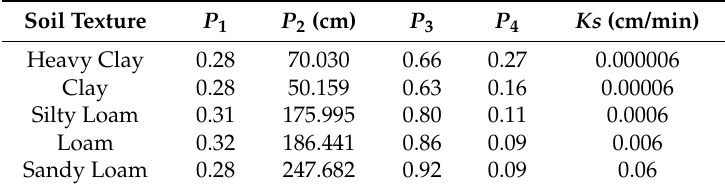
Table 2. The generalized parameters and saturated hydraulic conductivity ( Ks ). Soil Texture P 1 P 2 (cm) P 3 P 4 Ks (cm/min) Heavy Clay